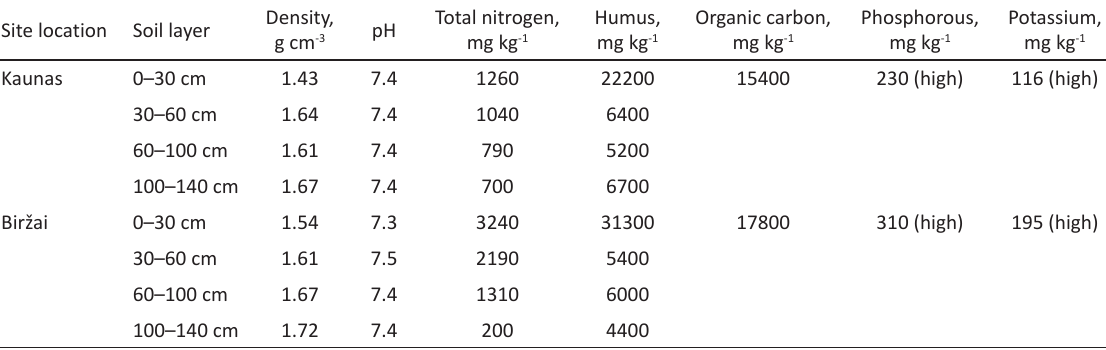
Table 2. Soil chemical and physical properties at experimental sites Site